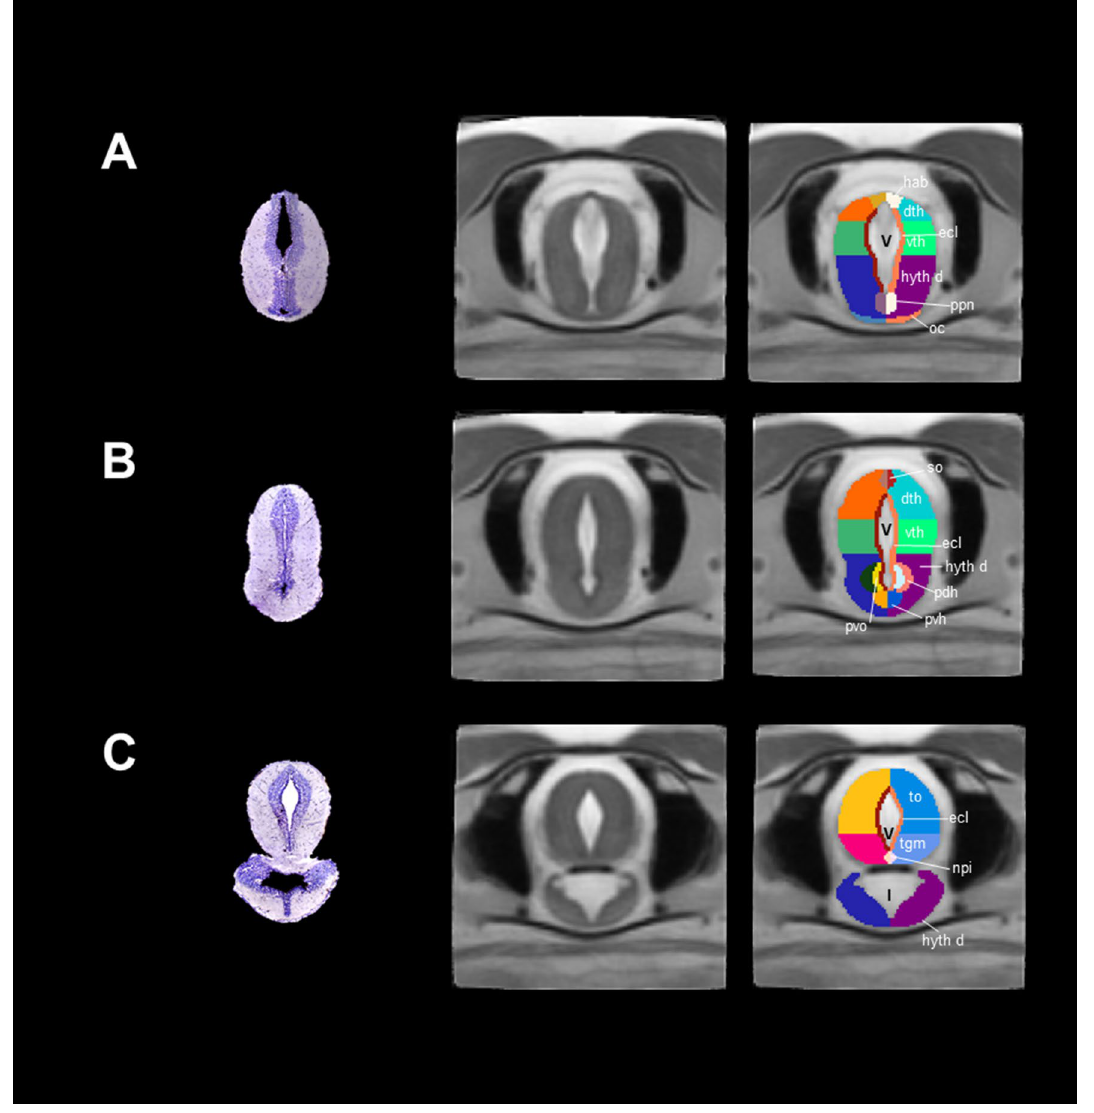
Figure 4. Coronal sections and slices of the diencephalon/mesencephalon of Ambystoma mexicanum . Columns left, central and right depict the Nissl-staining histological sections; the MRI images and the manual segmentation, respectively created from our template. ( A ) dorsal (dth) and ventral thalamus (vth), subcommissural organ (so), optic chiasm (oc), habenula (hab); ( B ) regions surrounding the floor of the third ventricle in the hypothalamus dorsalis (hyt d) such as the paraventricular organ (pvo), pars dorsalis (pdh) and pars ventralis hypotalami (pvh); ( C ) the mesencephalon, including the optic tectum (to), tegmentum (tgm)and interpeduncularis nucleus (npi). V ventricle, I infundibulum are tegmentum (Fig. 6E–H); however, no myelin staining was observed in the anterior part of the brain, i.e . , in the olfactory bulb and telencephalon (Fig. 6D). These results were confirmed using coronal sections, in which we are able to detect myelin in the lateral/medial forebrain blundle/amygdaloid complex (Fig. 7A), the ventral thalamus (Fig. 7B) and the optic tectum/tegmentum (Fig. 7C). Both, sagittal and coronal sections showed that medulla oblongata is a myelin rich region, particularly in the white matter, confirming the specificity of the myelin stain- ing method (Fig. 7D). We were not able to detect myelin in the anterior part of the axolotl brain. This discrep- ancy could have different explanations. In the developing mammal, the myelination process starts in the spinal cord and gradually covers the posterior part of the CNS postnatally 46,47 . It is possible that even if the juvenile stage of the axolotl brain is not fully myelinated, the adult brain could contain myelin in the anterior part of the brain. Another explanation could be that the axolotl lost the capacity to myelinate axons in the anterior part of the brain as result of neoteny and/or other unidentified physiological events. In this context, all amphibians go through dramatic transformations that occur in the transition from a pre- to a post metamorphic stage; however, axolotl can retain juvenile features throughout adulthood (neoteny/paedomorphism), resulting in adult (repro- ducing) individuals that maintain juvenile (larval) traits). Lastly, amphibian myelin composition might not be detected by Black Gold II. Even if this reagent is indeed myelin specific, amphibians have shown to present